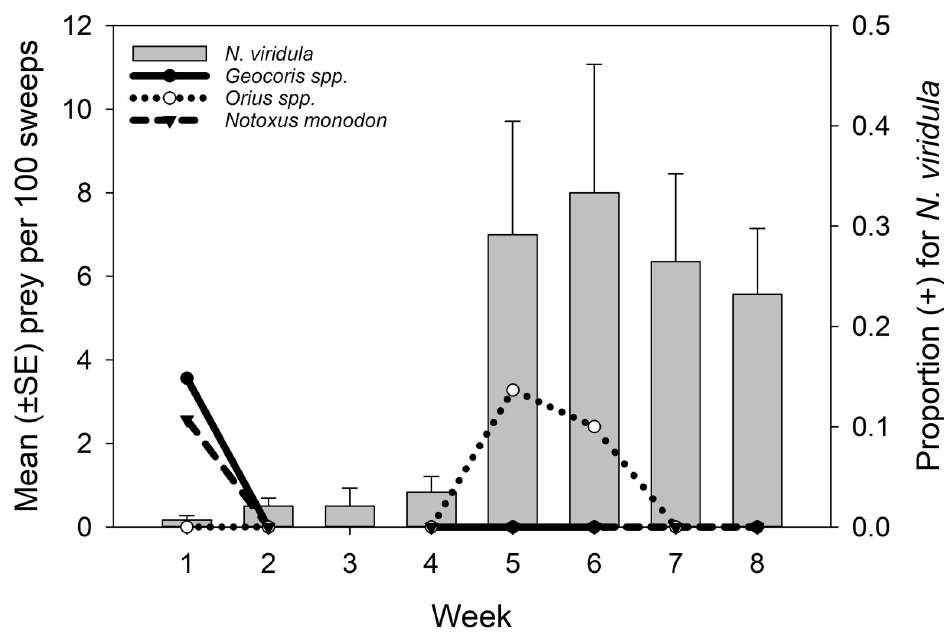
Fig 1. 2011 Gut content results. Mean ( ± SE) number N . viridula per 100 sweeps and the proportion Geocoris spp ., Orius spp , and Notoxus monodon testing positive for N . viridula DNA by sampling week, 29 July– 7 October 2011. In sampling week 3, only stink bugs were collected.